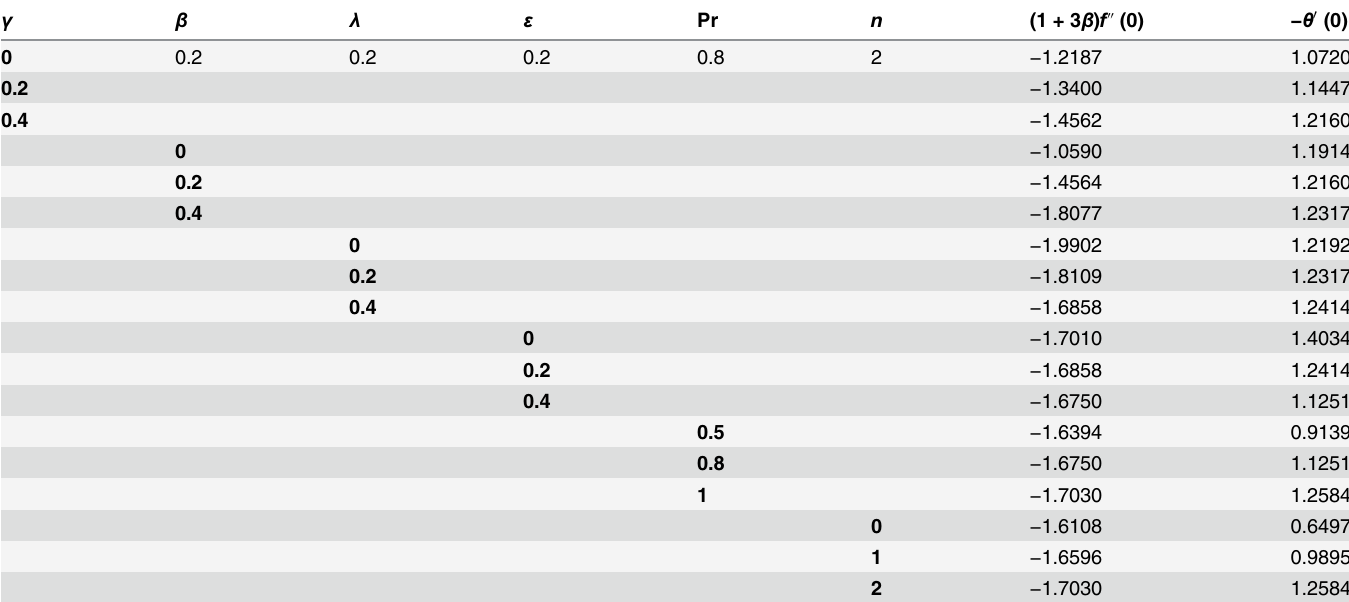
Table 4. Effects of various involved parameters on the skin friction coef fi cient and local Nusselt number.